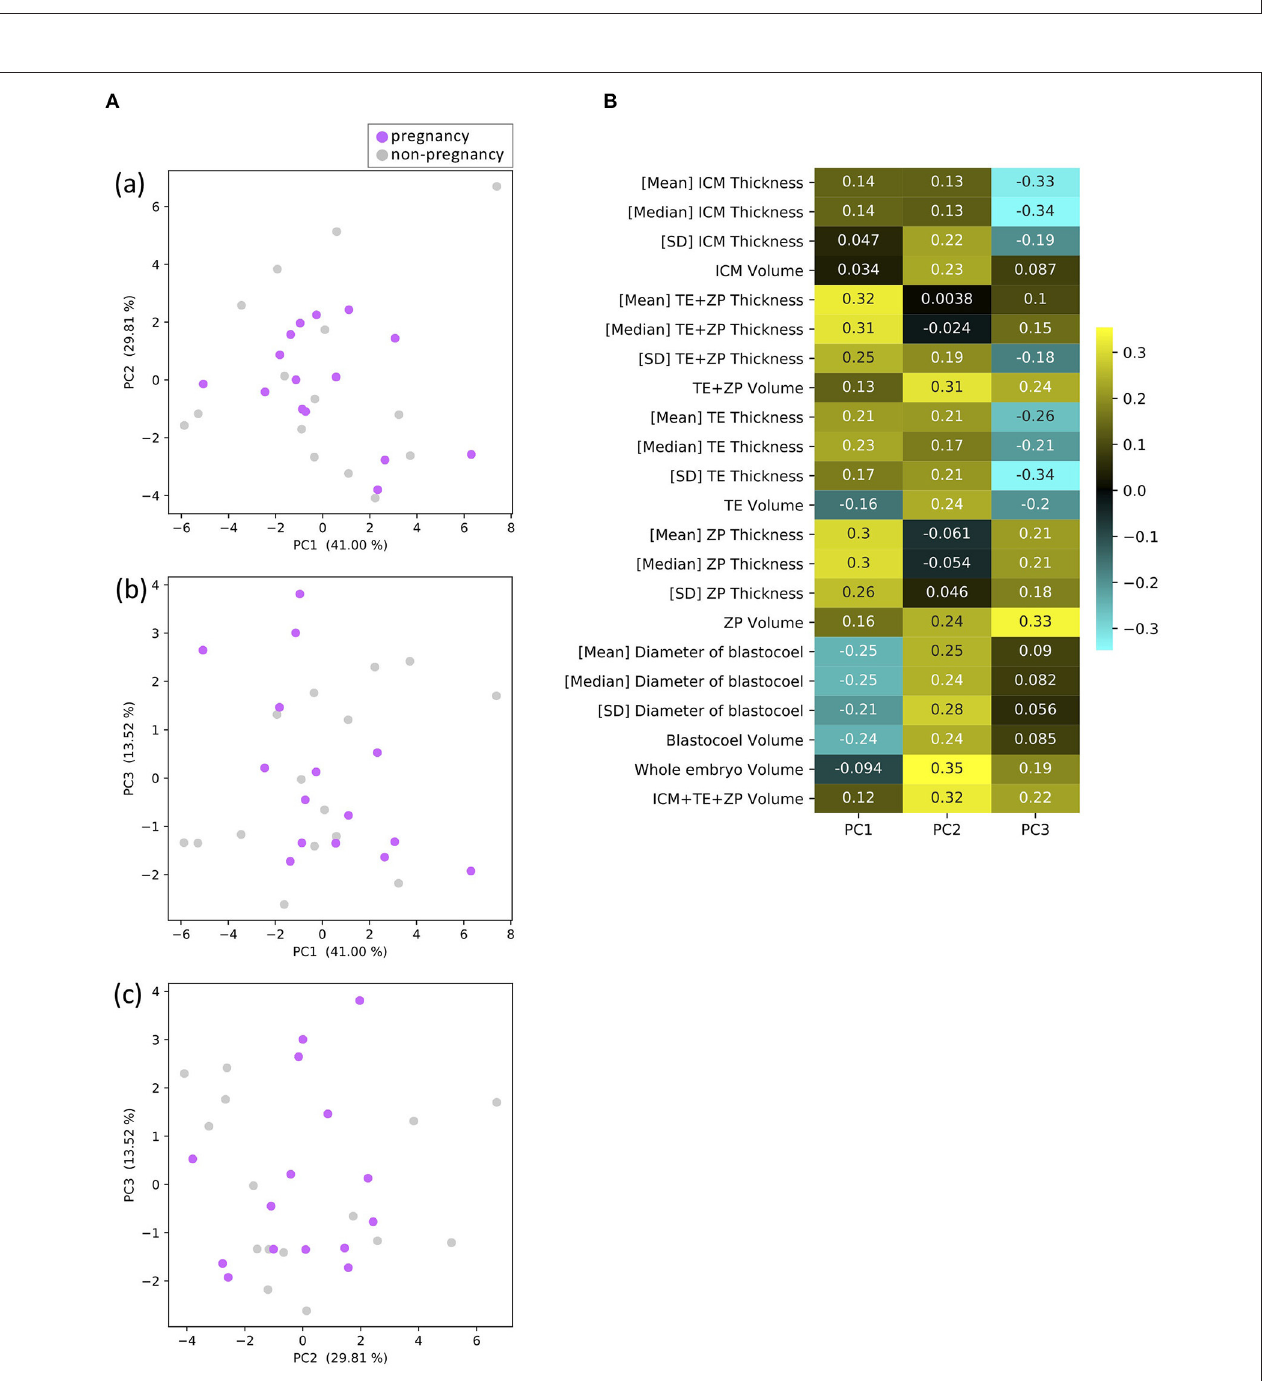
FIGURE 8 | (B) Parameters related to the volume of each part of blastocyst (ICM, TE, ZP, TE + ZP, ICM + TE + ZP, blastocoel, and whole embryo). (C) Parameters related toblastocoel diameter (mean, median, and SD). Statistical significance was analyzed using the Mann-Whitney U test. A value of p < 0.05 was considered statistically significant.